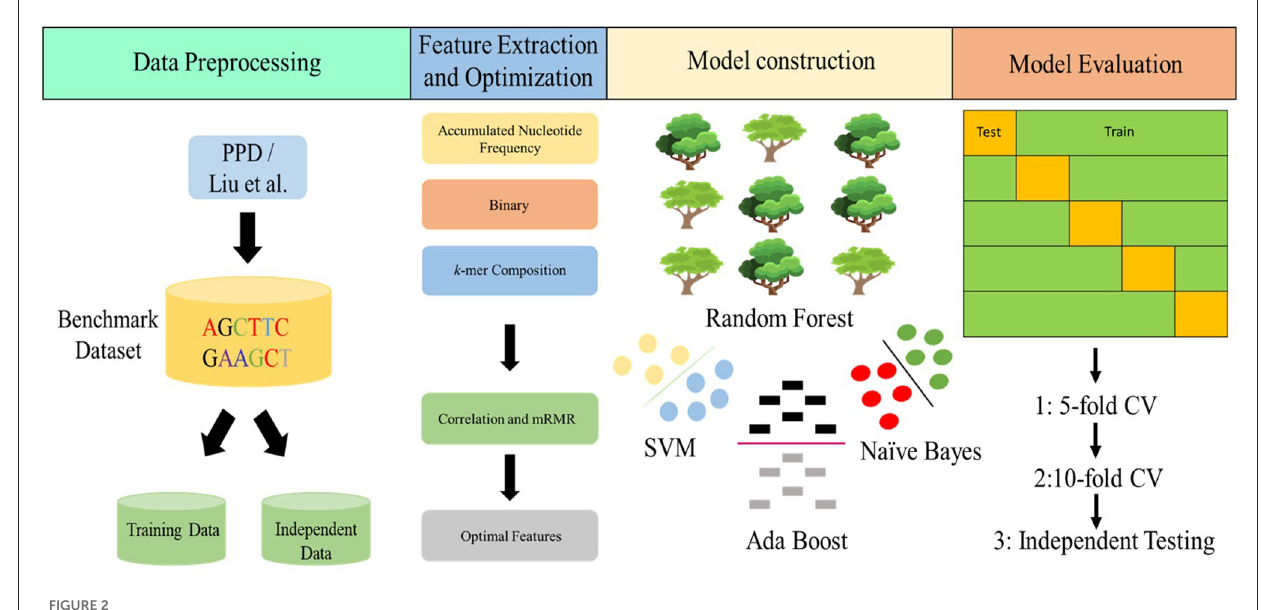
FIGURE2 Overall workflow of the